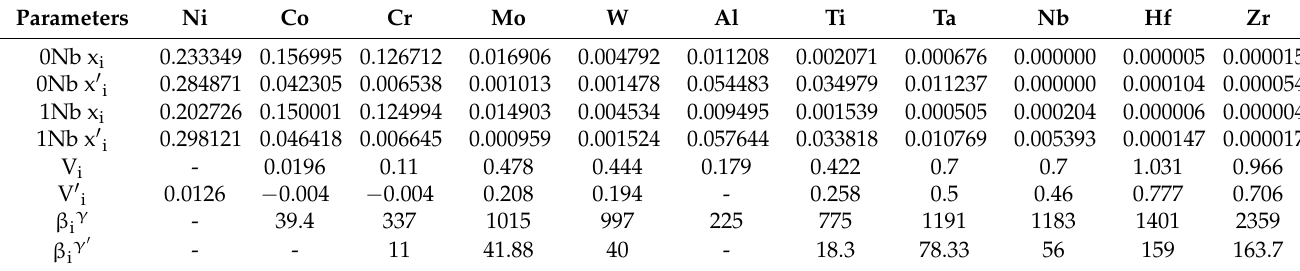
Table 2. The mole fraction (calculated at 800 ◦ C by Thermo-Calc software with the TTNI8 database) and Vegard coefficients of elements in γ and γ (cid:48) phase [26]. β i values of elements in γ and γ (cid:48) of Ni-based superalloys at room temperature (MPa/at.% 1/2 )